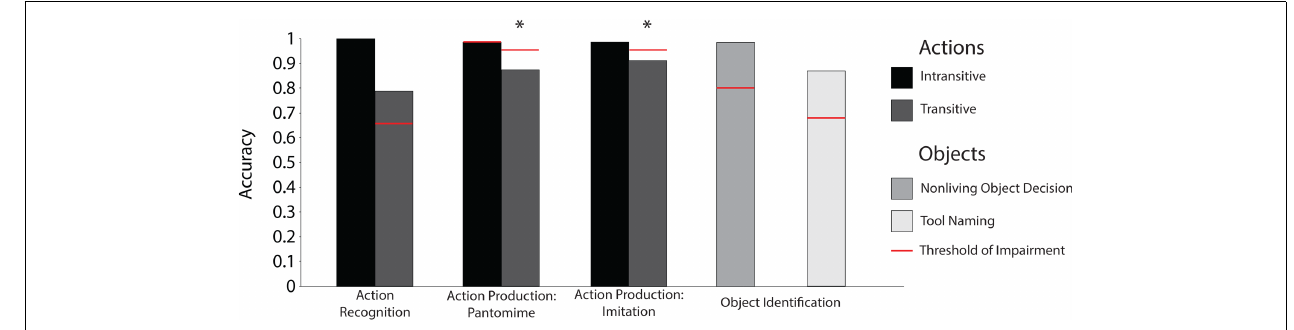
FIGURE 8 | CaseAA’s principal dissociation between the ability to use and name manipulable objects. * denotes a significant impairment relative to control participants.The threshold of impairment is plotted two standard deviations below control participants’ mean.